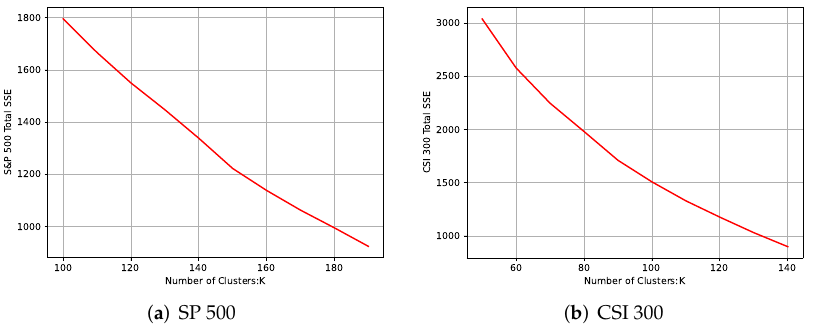
Figure 6. The relationship between SSE and K.